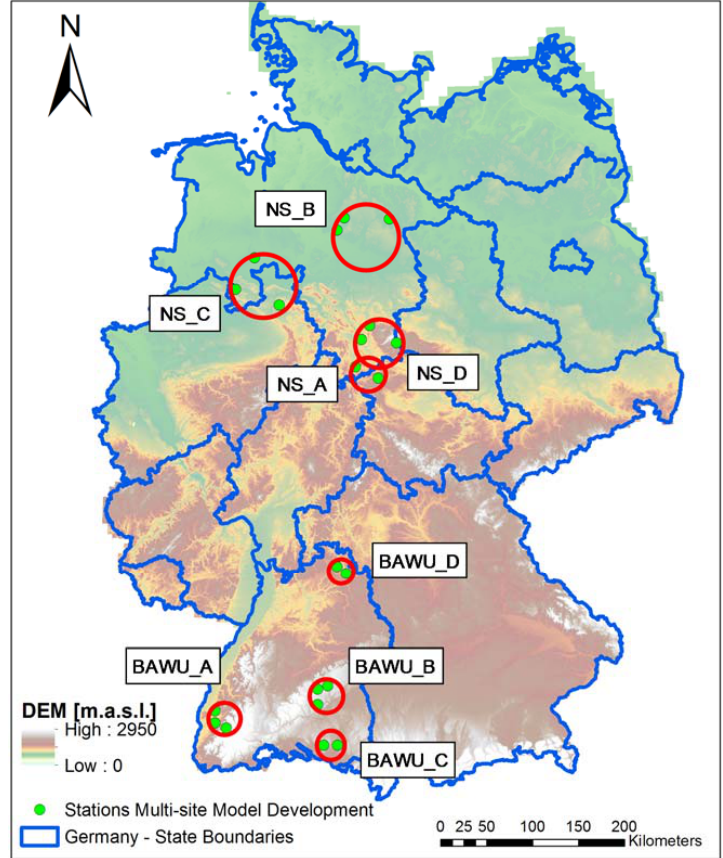
Figure 3. Location of rain gauge stations and groups used for developing the model. The red circles indicate the areas involved for each case.